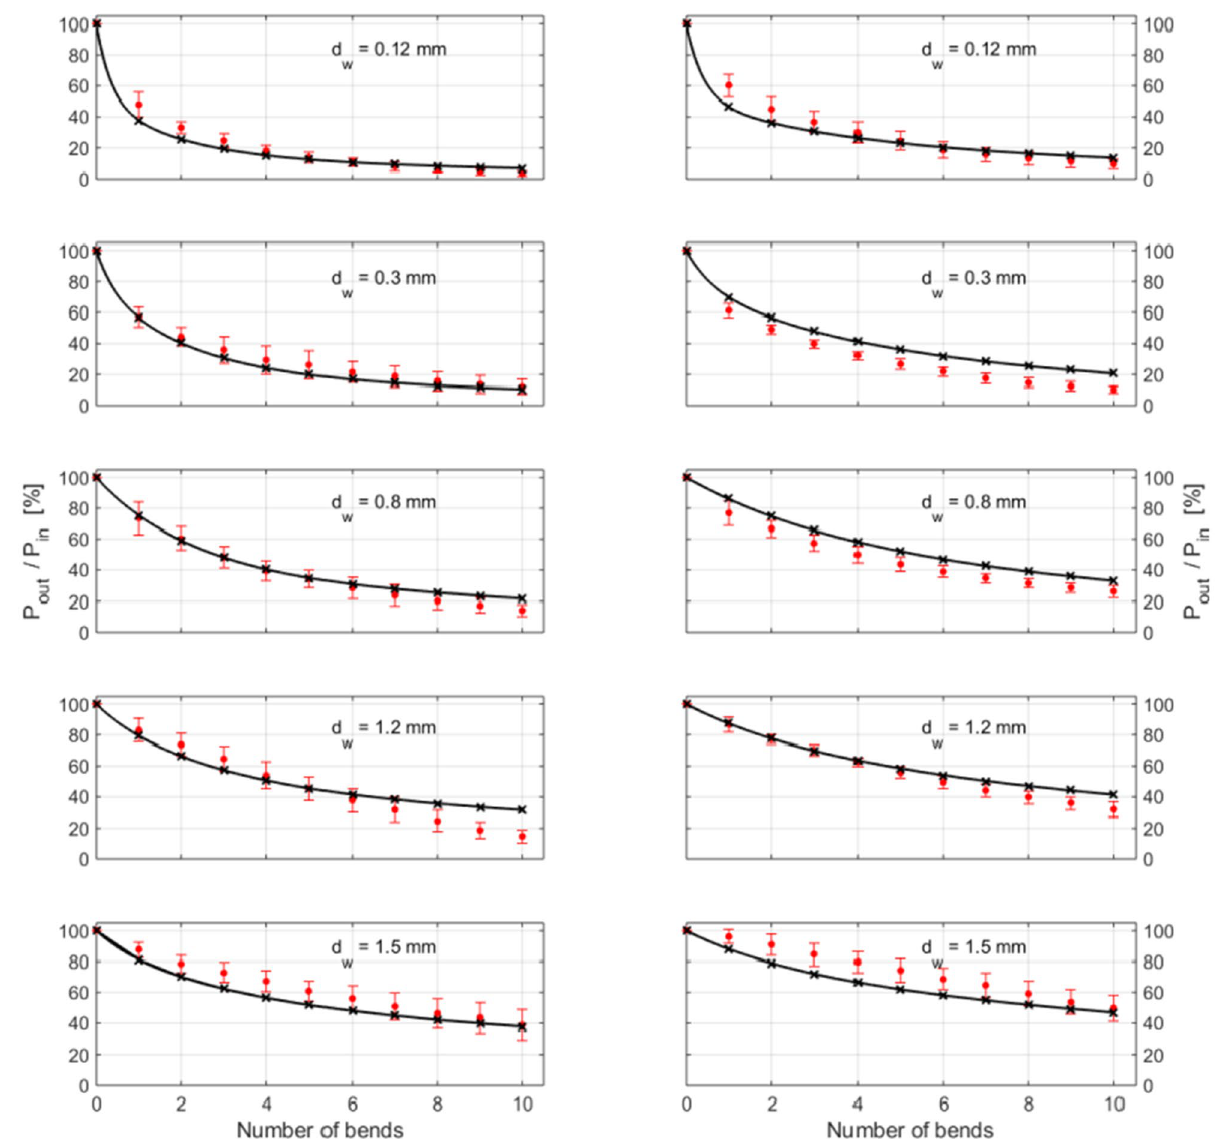
Figure 5. Comparison of measured and simulated data for all bending radii, for both fibres (left: fibre 1143; right: fibre 1144). Circles with error bars: measured data ( n = 10); crosses: ray-tracing results; solid lines: fitting according to Eq.